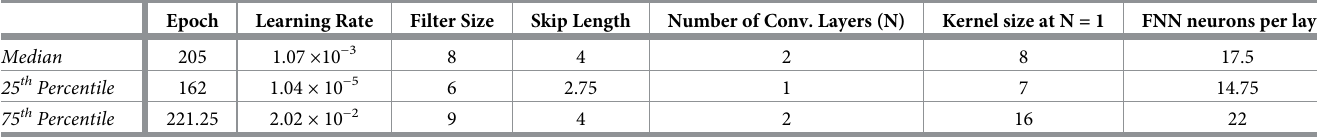
Table 6. CNN hyperparameters.